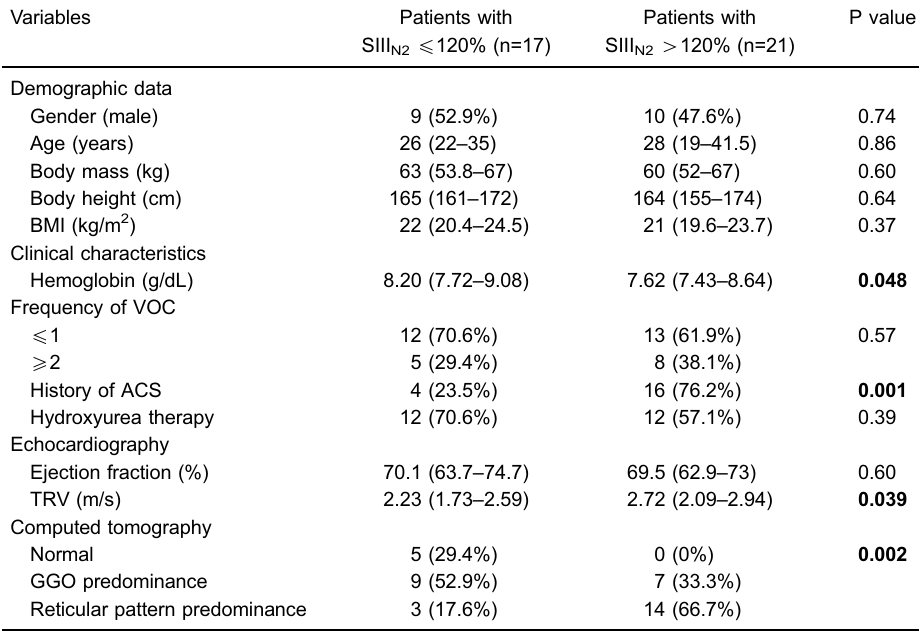
Table 1. Demographic, clinical, echocardiography and computed tomography data according to phase III slope of the nitrogen single-breath washout test (SIII N2 ).